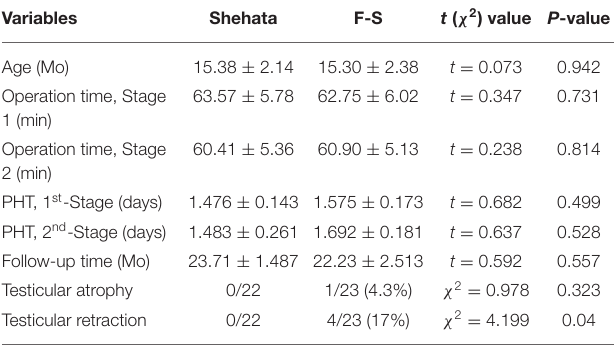
TABLE 1 | Demographic data of the Shehata and F-S technique